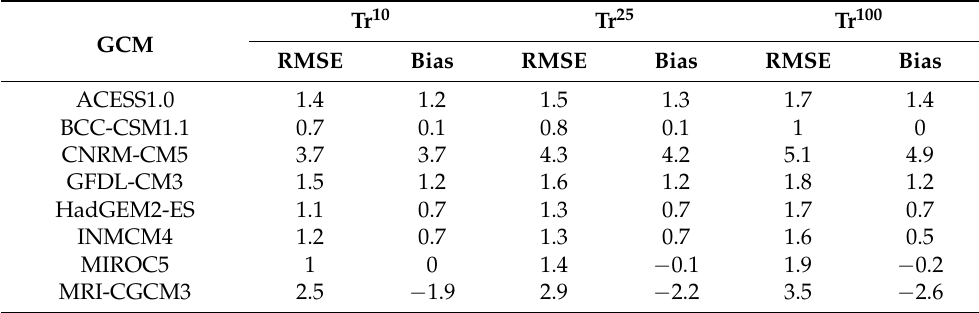
Table 5. Wave height ( Hs ), RMSE (meters), and bias for the winter months considering the 10-, 25-, and 100-years return